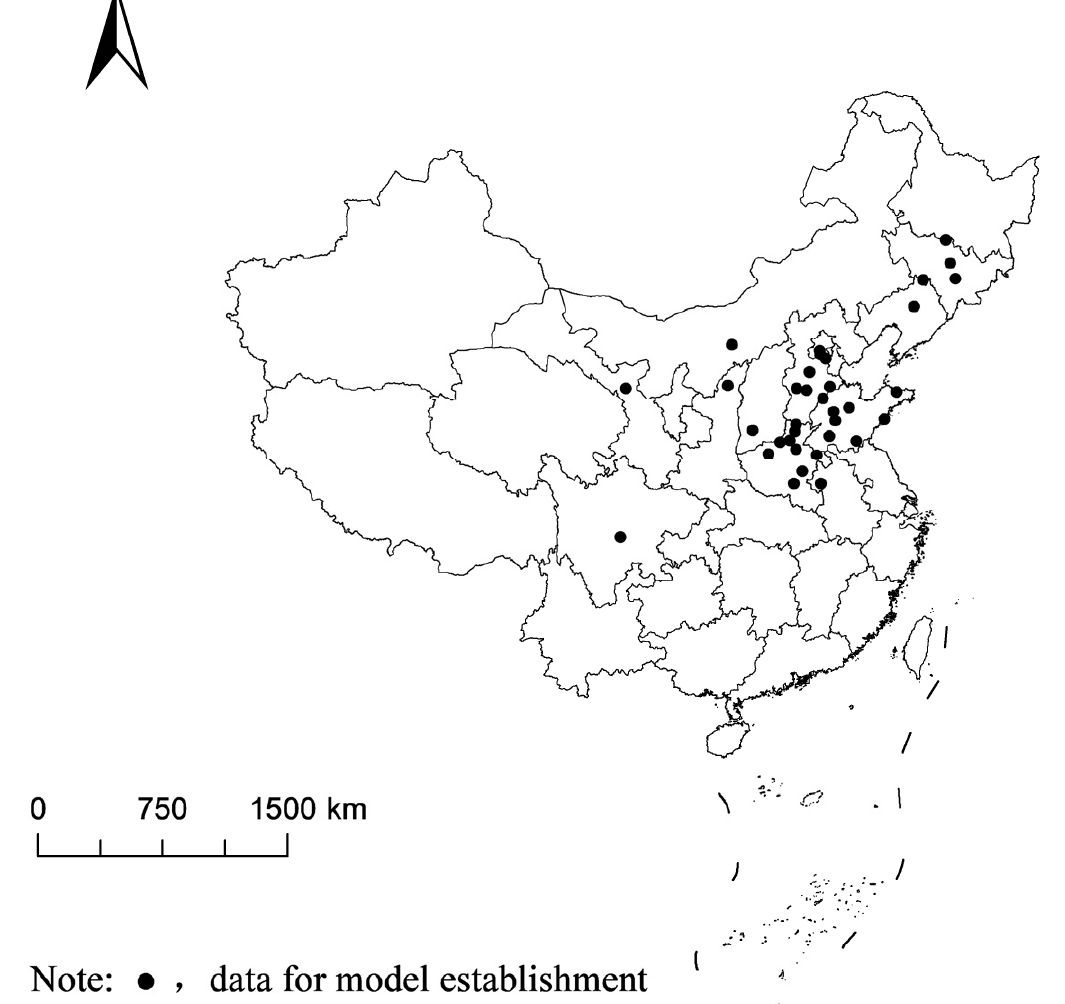
Figure 1. Regional distribution of summer maize data sources. Note: This drawing was produced based on the standard map no. GS(2020)3183 downloaded from the standard map service website of the National Administration of Surveying, Mapping and Geographic Information, without modification of the base map.